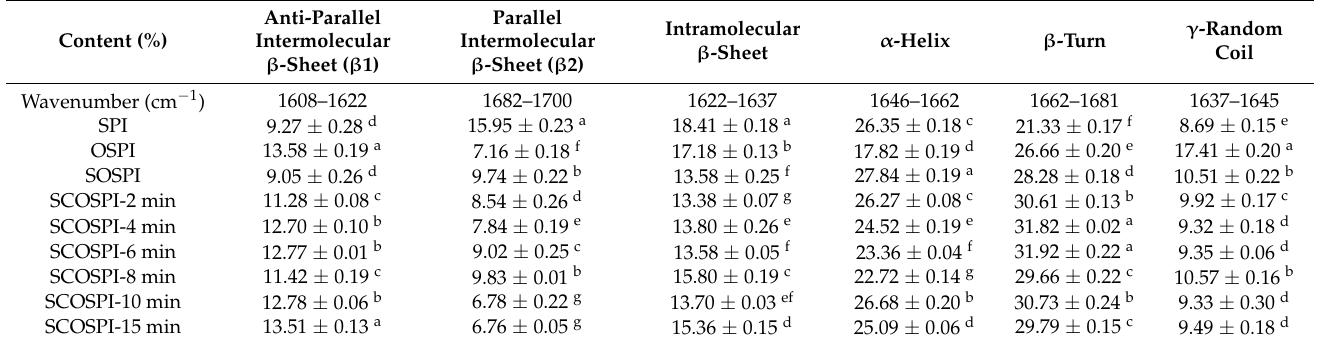
Table 2. Secondary structure content of natural, oxidized soybean protein, and cavitation jet treated on soluble soybean protein oxidized accumulates at several times (2, 4, 6, 8, 10, and 15